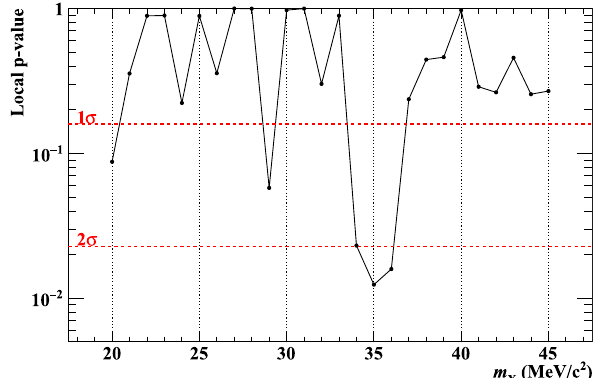
Fig. 18 Local p-value under null hypothesis as a function of assumed m